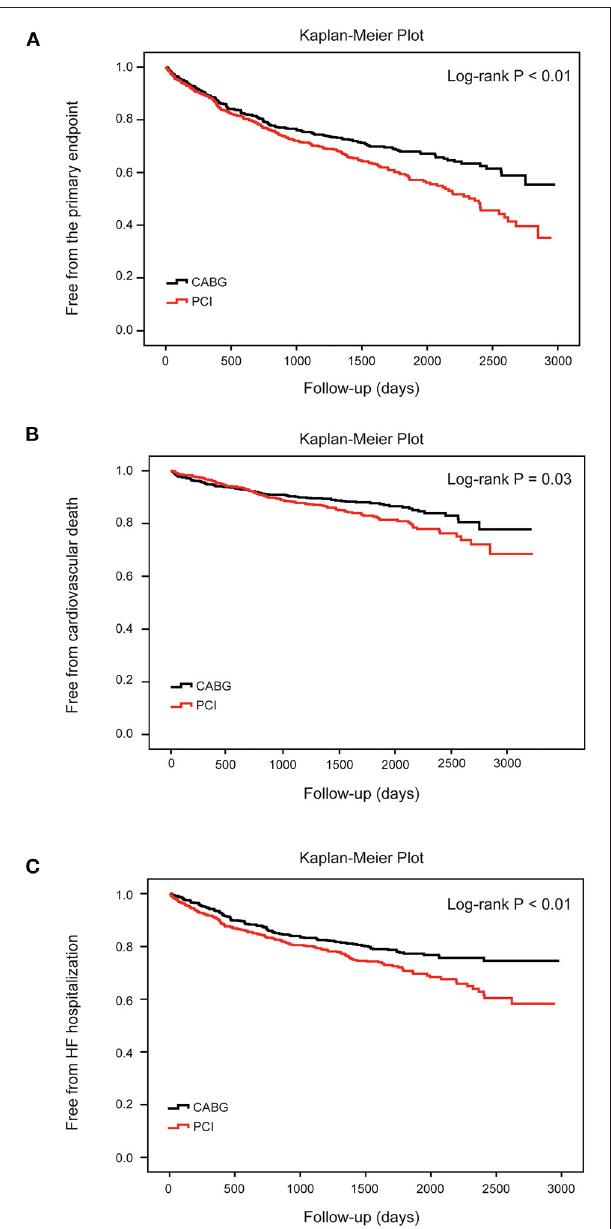
FIGURE 2 | Cumulative risks for the primary and secondary endpoints in all patients. Kaplan–Meier survival curves for the primary endpoint (A) (log-rank P < 0.01), cardiovascular death (B) (log-rank P = 0.03) and heart failure hospitalization (C) (log-rank P < 0.01) according to different therapy strategies in all patients. Differences between the two procedures were evaluated by the log-rank test. CABG, coronary artery bypasses grafting; HF, heart failure; PCI, percutaneous coronary